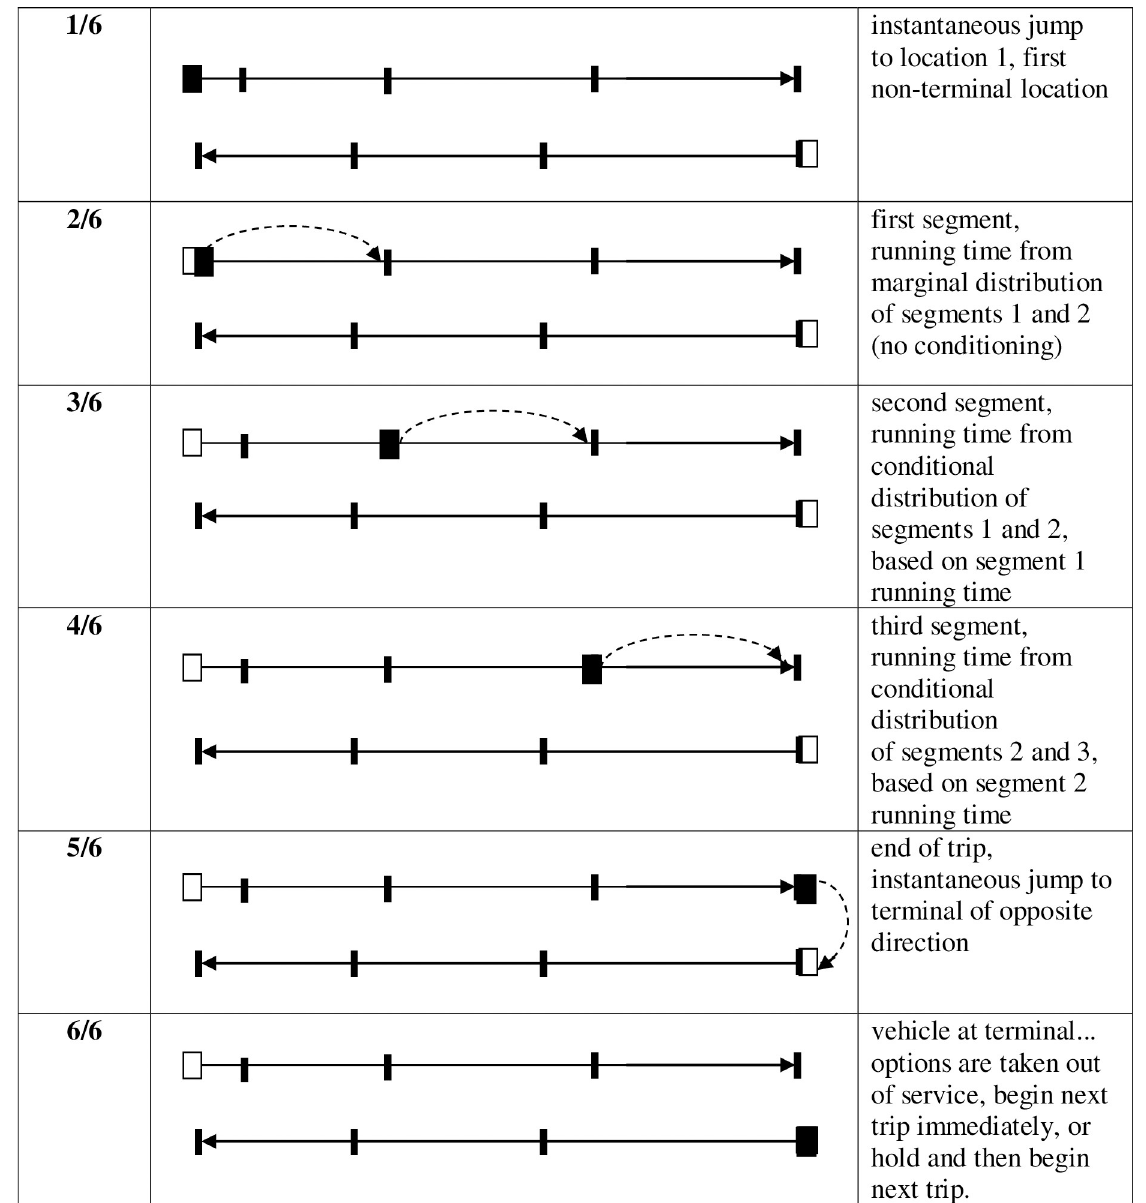
Fig 5. Walk-through of events for a single